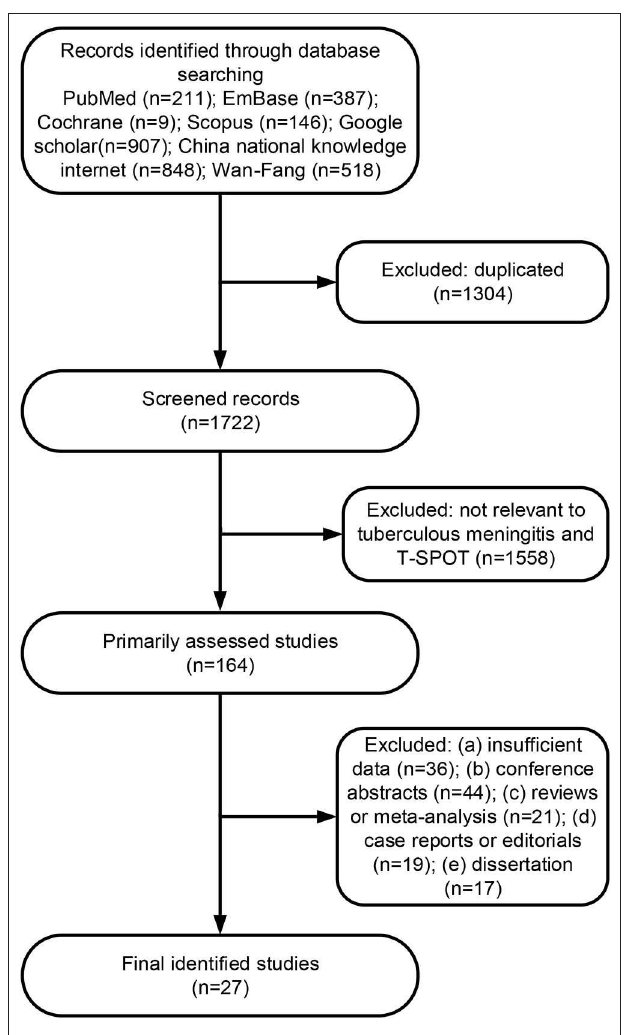
FIGURE 1 | Flowchart diagram for study selection and